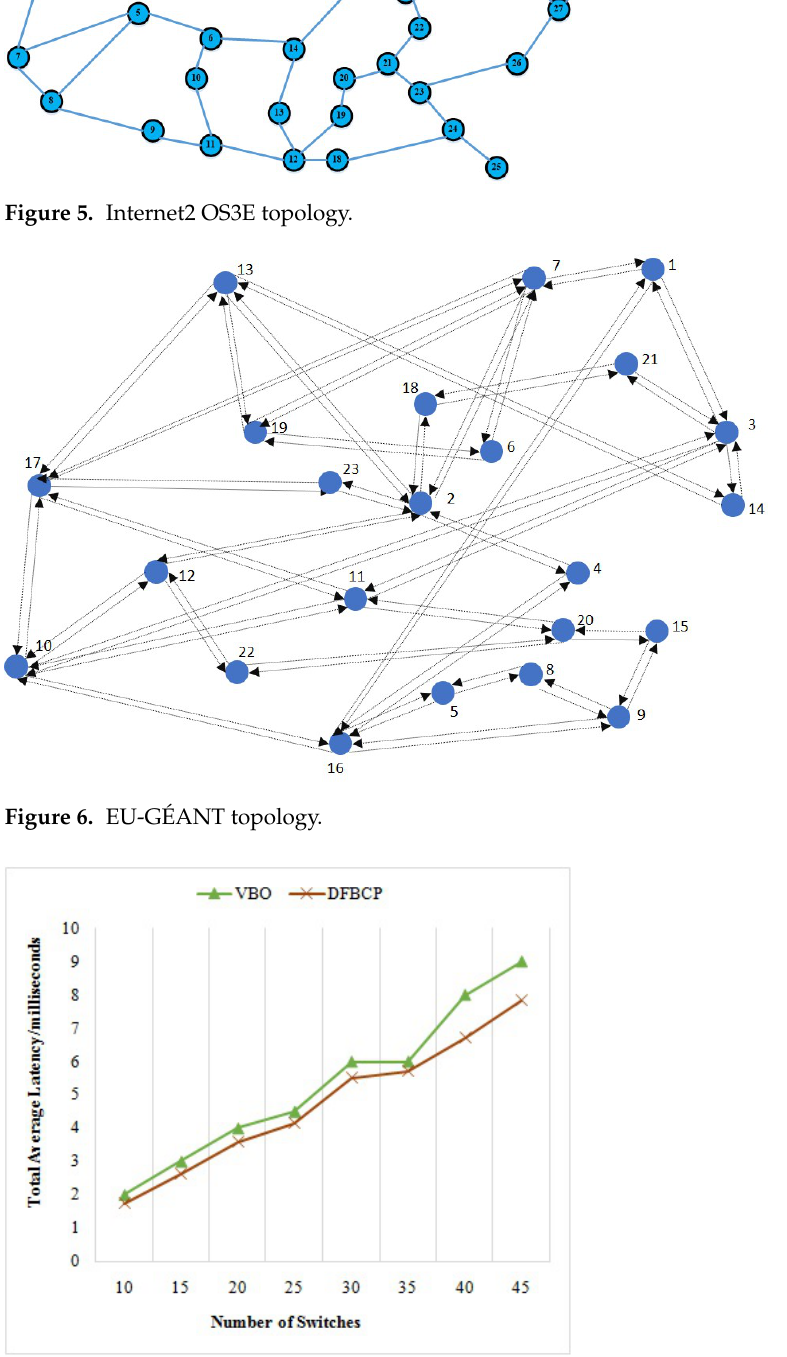
Figure 7. Convergence plots for uncapacitated controller placement problem for Internet2 OS3E